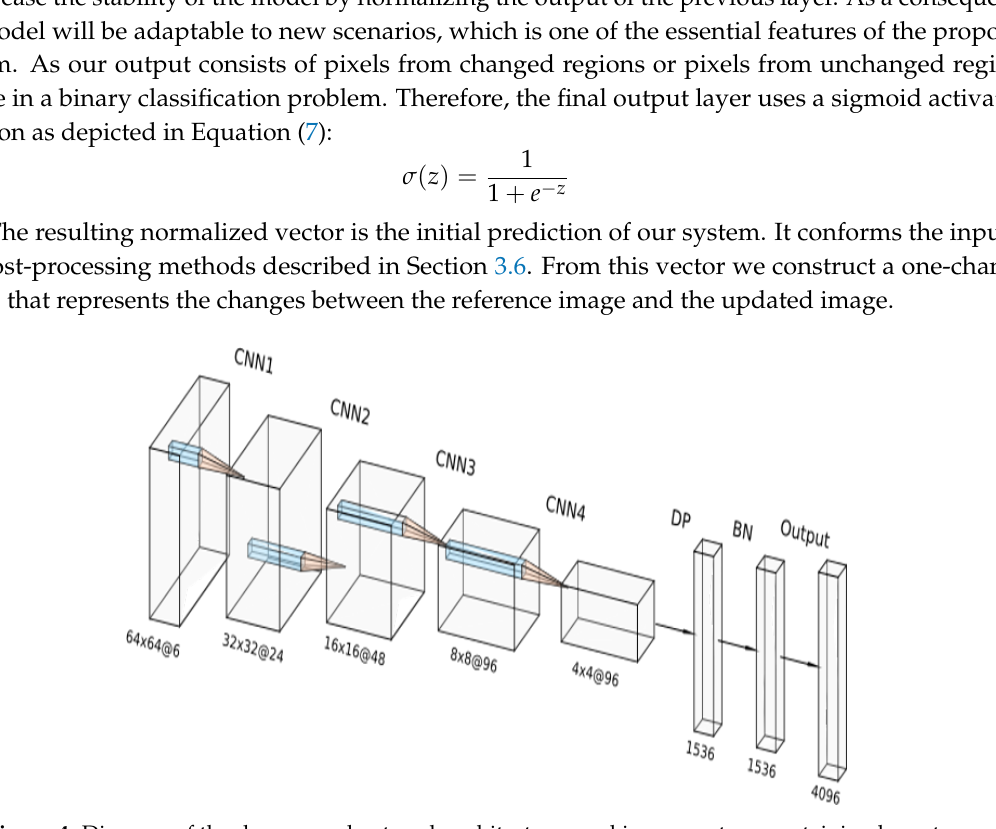
Figure 4. Diagram of the deep neural network architecture used in our system, containing layer types and dimensions. Table 1. Layer description of the convolutional neural networks (CNNs) which conform the first part our